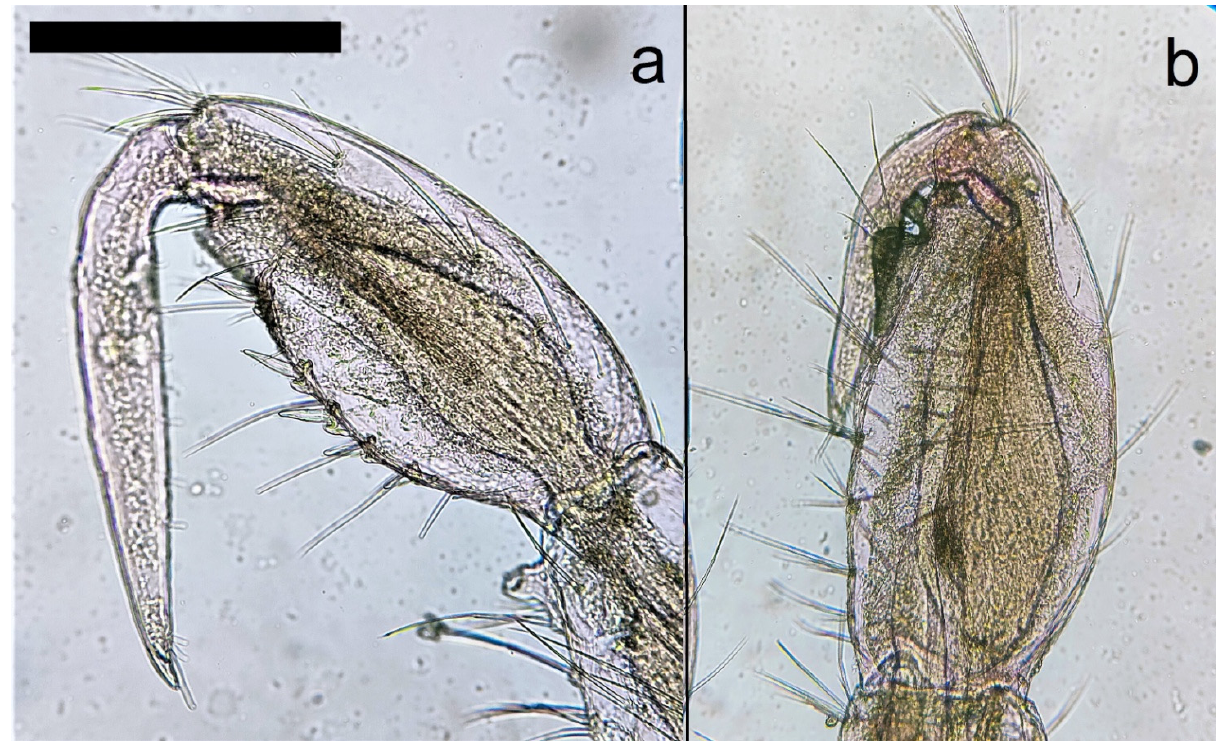
Figure 5. Megamphosus katagani : coxa 2 at different levels of magnification. Scale bar: 0.1 mm. Photo credit: Emanuele Mancini.